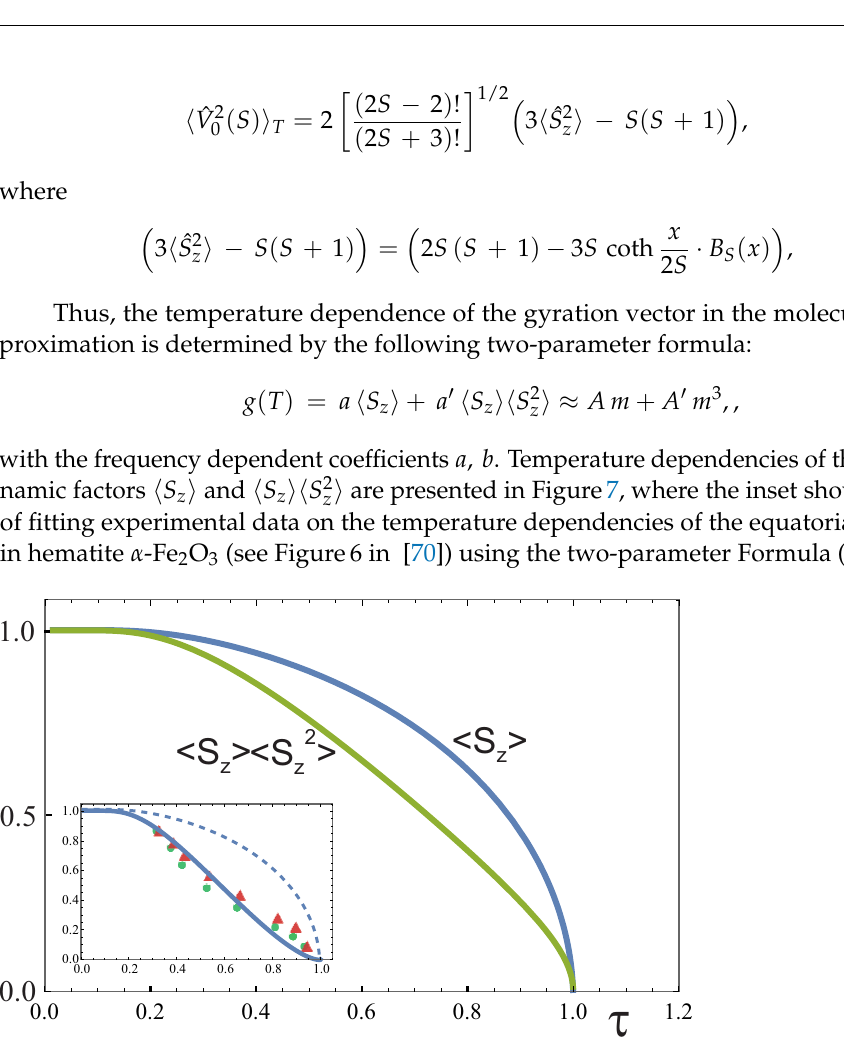
Figure 7. Temperature dependence of the normalized thermodynamic quantities determining the temperature dependence of the circular MOE. The inset shows an example of fitting the experimental data on the temperature dependencies of the equatorial Kerr effect in hematite α -Fe 2 O 3 (see Figure 6 in [70]) using the two-parameter Formula (56). Dotted curve is the (cid:104) S z (cid:105)